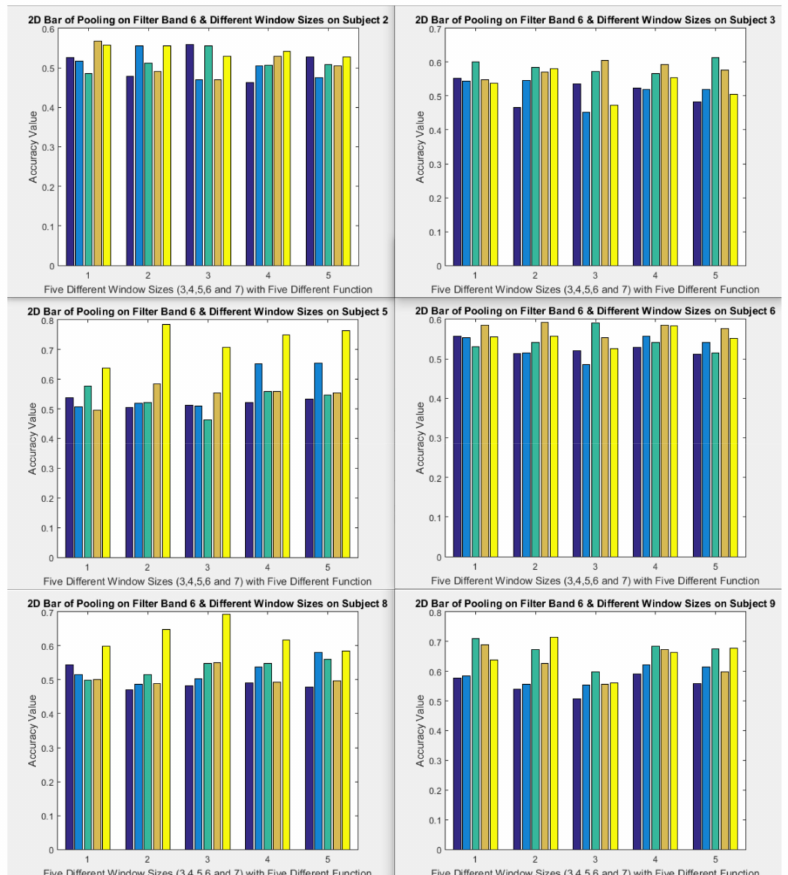
Figure 12. Reduction data based on pooling model on some subjects (2, 3, 5, 6, 8, 9) and filter banks with different window sizes for FB 6 and RF for 10 iterations.